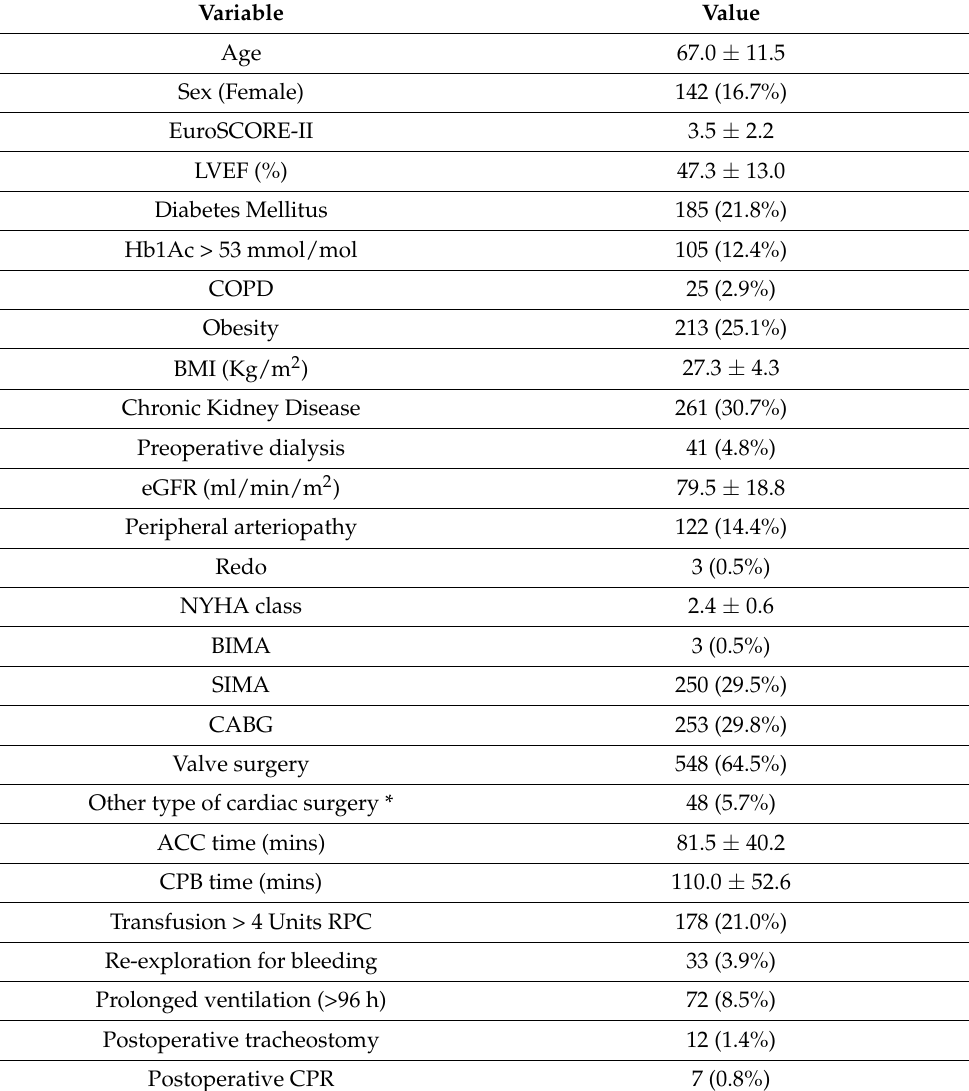
Table 1. Baseline characteristics and perioperative data of the